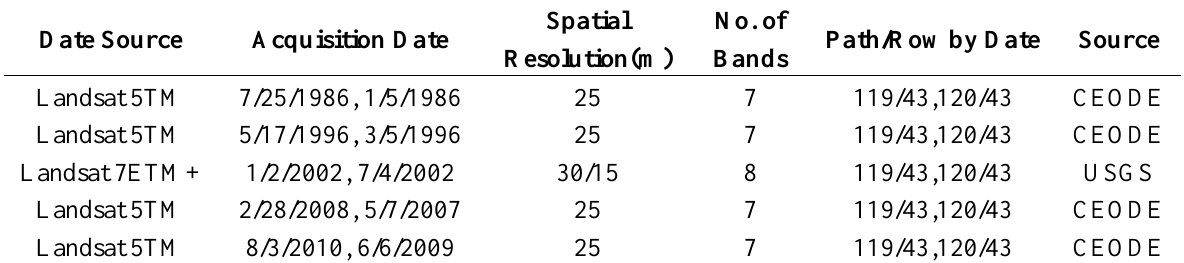
Table 1. Characteristics of the satellite images